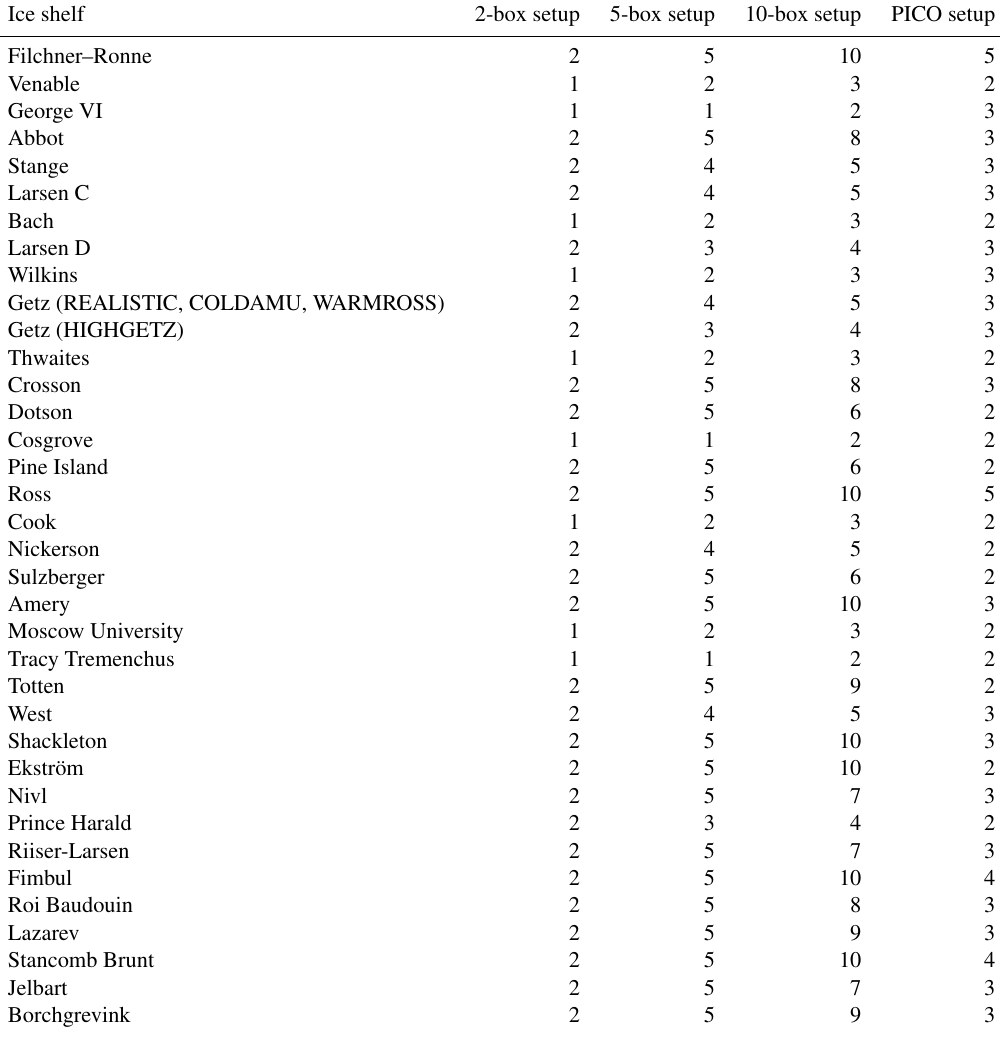
Table D1. Number of boxes in the three different box model setups. When the number is smaller than the name of the setup, it means that the number of boxes needed to be reduced to have an ascendant slope or that the ice shelf is too small for this number of